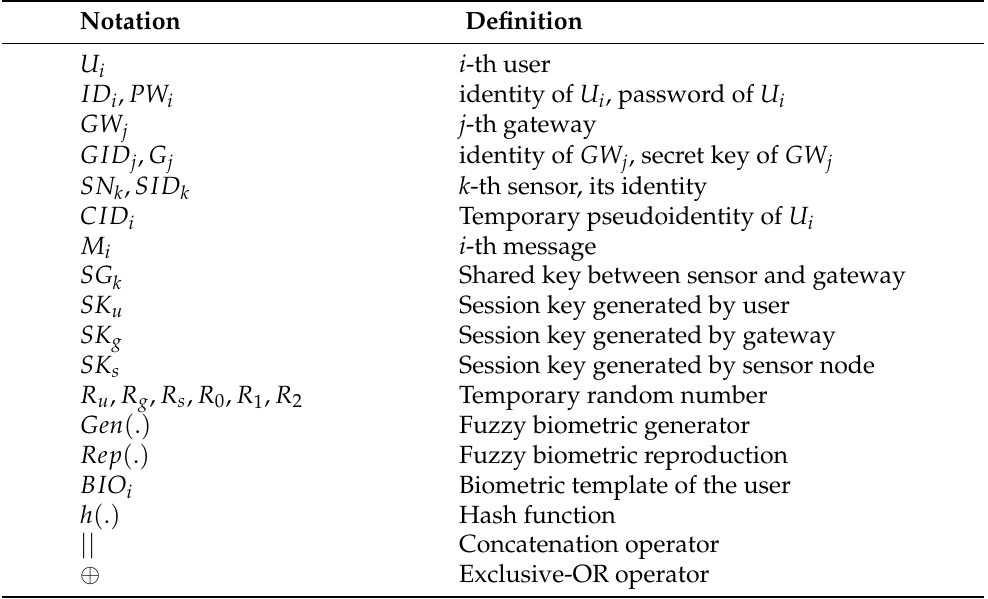
Table 2. Notations and definitionsof the proposed scheme.